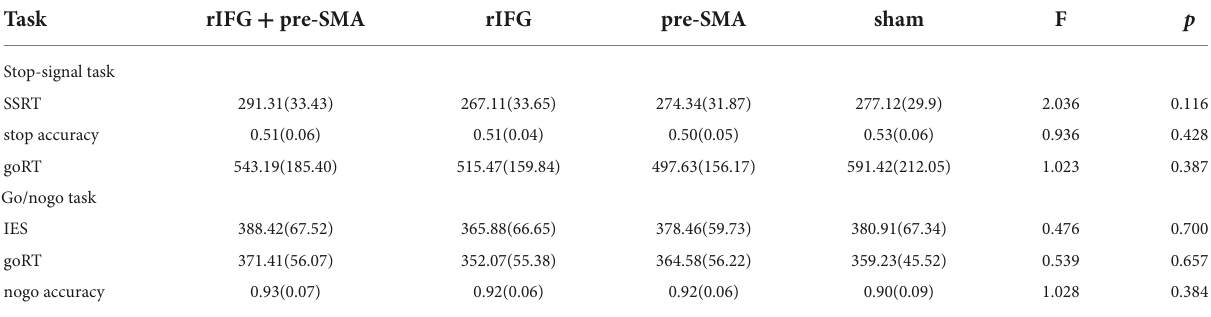
TABLE 3 Means and standard deviations of behavioral task performance at